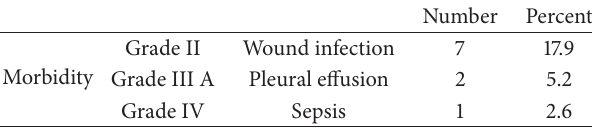
Table 3: Outcome based on 90-day